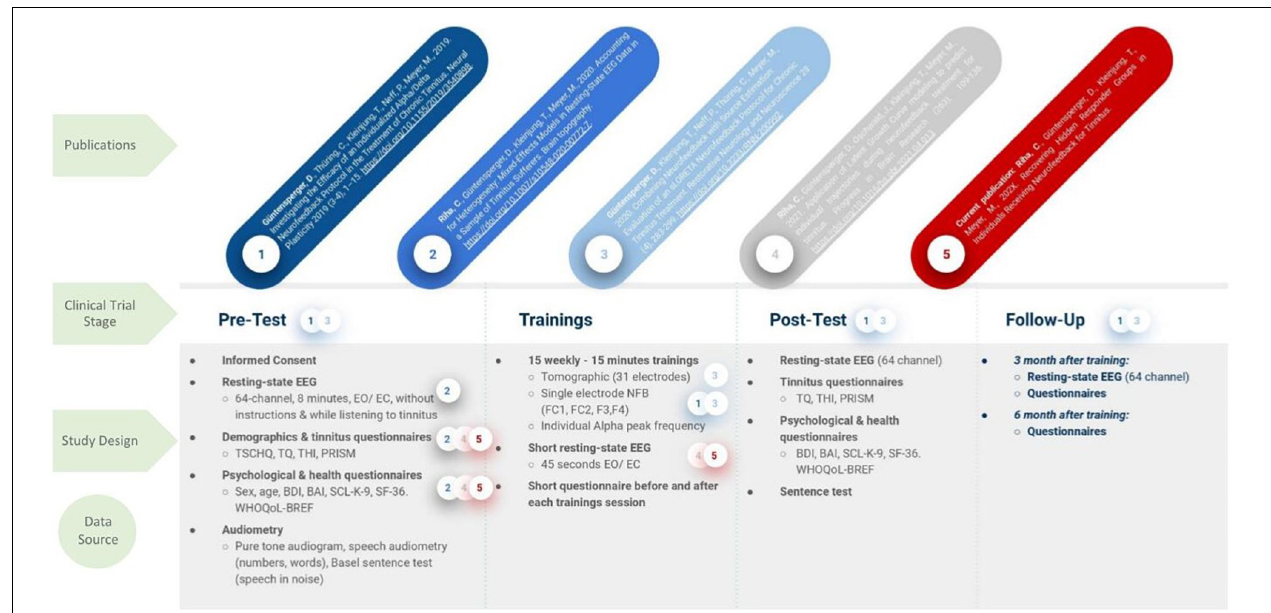
FIGURE 1 | Study Design of the clinical NFB trial by Güntensperger et al. (2019, 2020). Based on the original data a number of publications evolved, however, focusing on different aspects of the data set, according to the hypotheses. The used data sets are highlighted by a color coded circle with a number, which correspond to the publications in the first row. TSCHQ, Tinnitus sample case history questionnaire; THI, Tinnitus Handicap Inventory; TQ, Tinnitus Questionnaire; PRISM, Pictorial Representation of Illness and Self Measure; BDI, Beck Depression Inventory; SCL K 9, Symptom Checklist; WHO, World Health Organization Quality of Life; SF 36, Short Form Health Questionnaire.